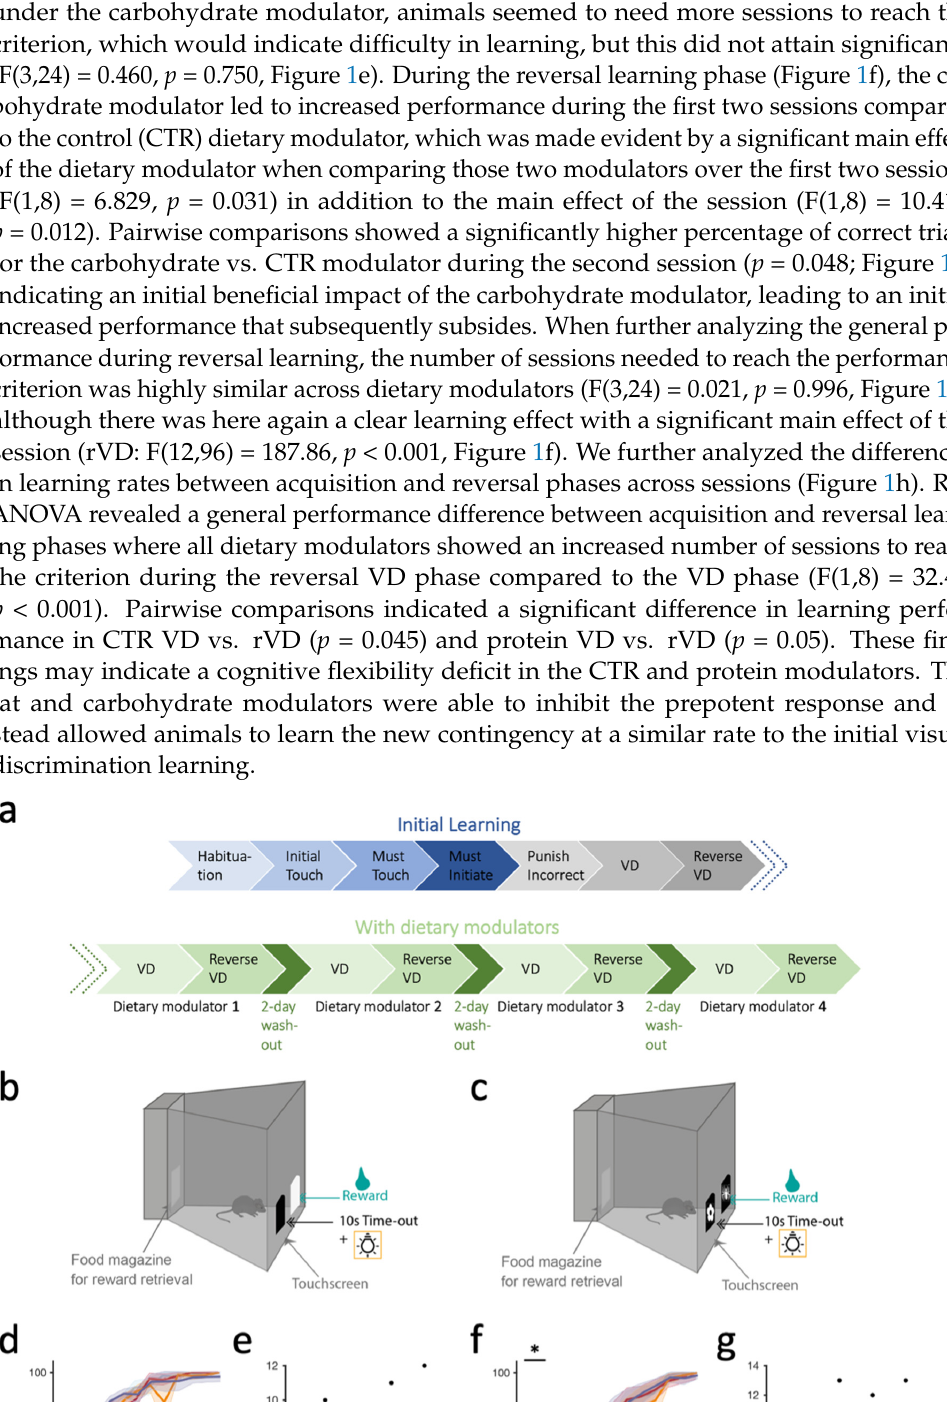
Figure 1. ( a ) Timeline of the visual discrimination (VD) and reverse VD (rVD) schedules during the learning phase (without dietary modulators) and under dietary modulators. ( b ) Schematic of the apparatus during the initial learning ‘Punish incorrect’ phase. ( c ) Schematic of the apparatus during the visual discrimination (VD) task (image pairs introduced). ( d ) Percentage of correct trials during the VD phase when all trials are considered under the different dietary modulators. ( e ) Number of sessions required to reach criterion for the VD phase under the different dietary modulators. Black dots indicate individual animals; animals with the same values overlap. ( f ) As in d, but for the re- verse VD phase; asterisk refers to CTR vs. carbohydrate. ( g ) As in e, but for the reverse VD phase. ( h ) Numbers of sessions needed to reach criterion (>80% for 3 consecutive sessions) across dietary modulators in the VD and rVD phases. Values reported as mean ± SEM ( d , f ) or mean + SEM ( e , g , h ). N = 9 mice. p -values reported as follows: * p ≤ 0.05. Carb.: carbohydrate, CTR: control.